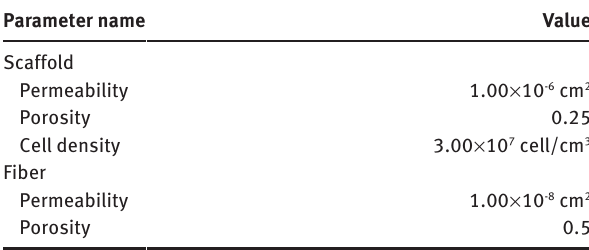
Table 1 Material properties for diffusive bioreactor analysis [49].